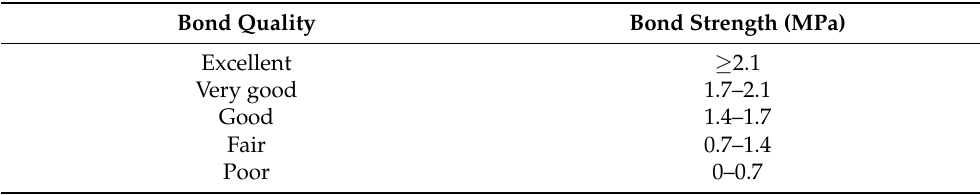
Table 6. Quantitative bond quality in terms of the tensile bond strength according to Sprinkel and Ozyildirim